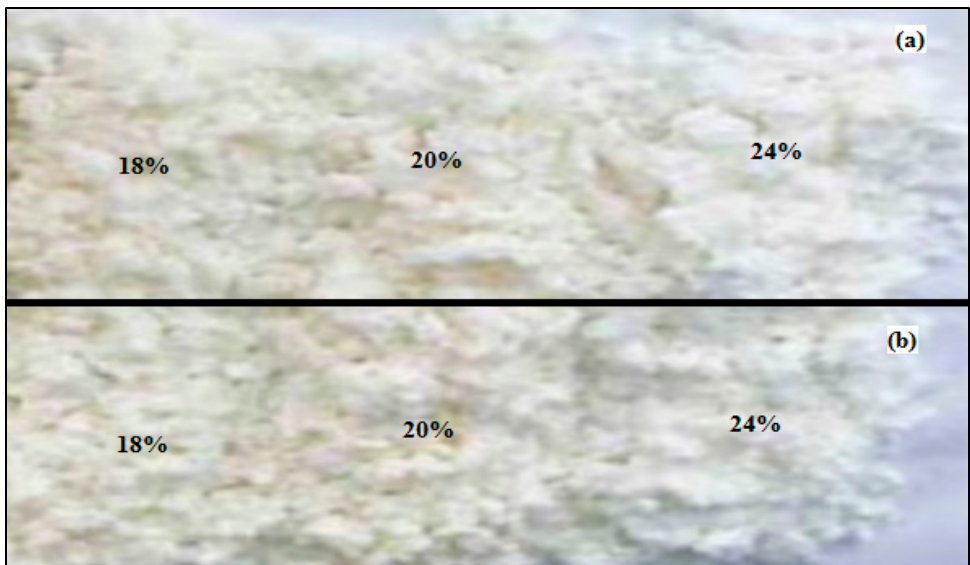
Figure 8. ( a ). Differences in brightness and density of WEFB fiber pulp with active alkali variations of 18%, 20% and 24%; ( b ). Differences in brightness and density of SEFB fiber pulp with active alkali variations of 18%, 20% and 24%.